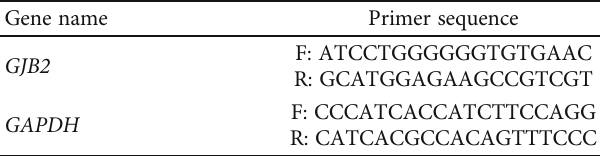
Table 1: Primer sequence of GJB2 and